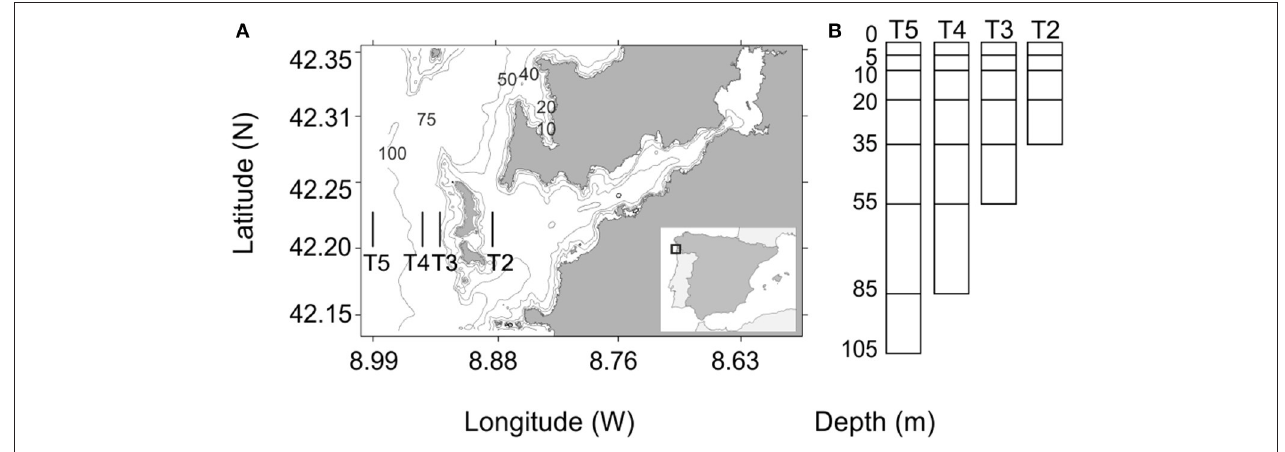
FIGURE 1 | (A) Map of the study area showing the four transects performed in 2012 and 2014. (B) Depth layers sampled for each different transects.